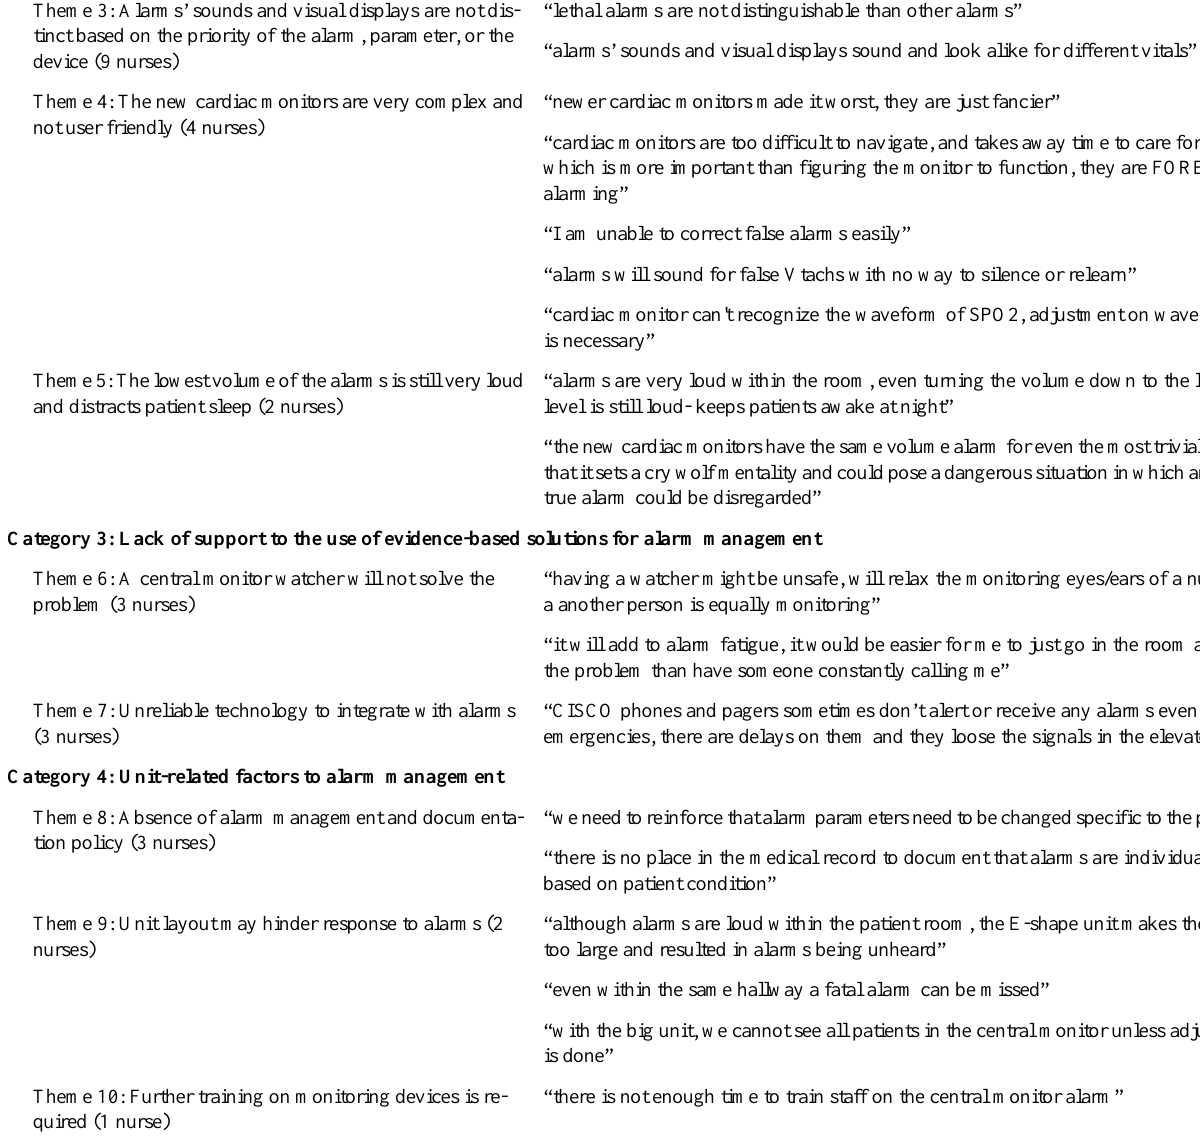
Examples of commentsCategories and